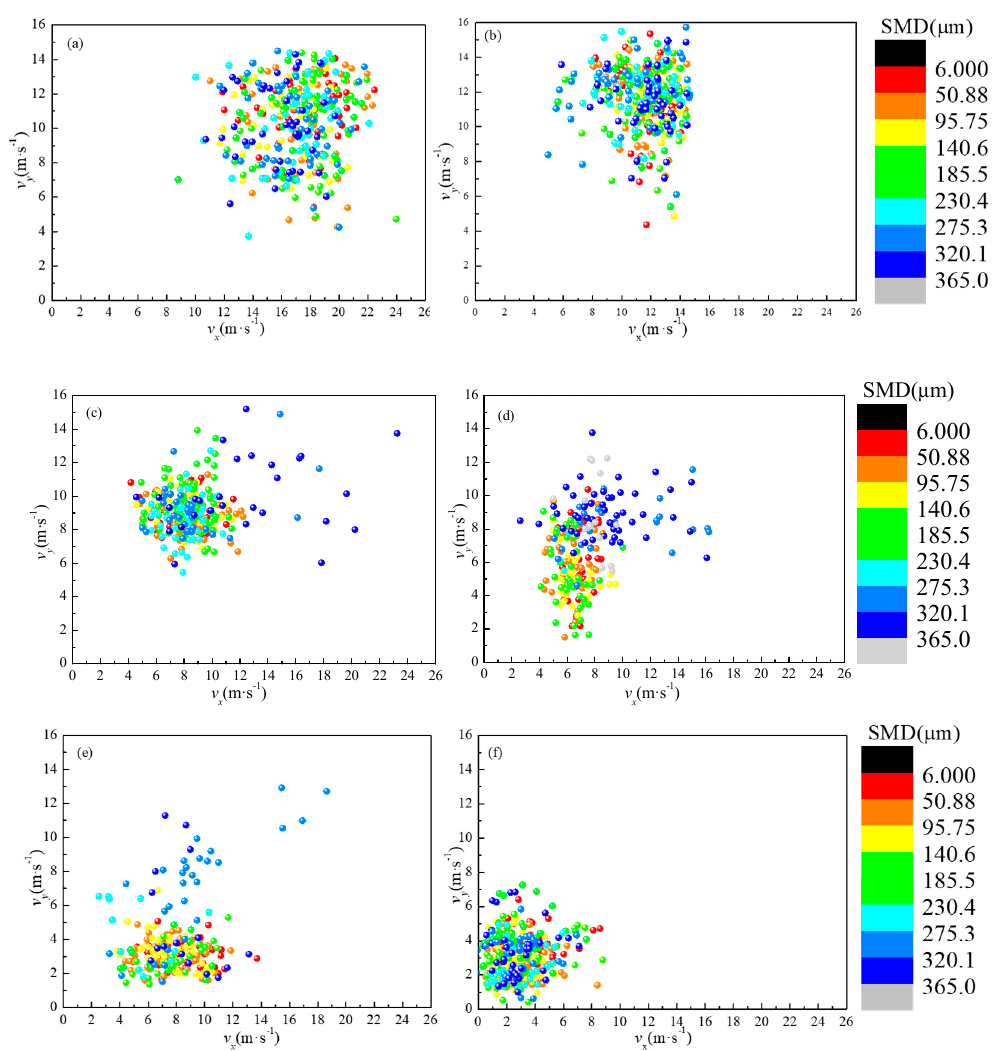
Figure 12. Joint particle size–velocity distribution scatter plot: ( a ) X = 50 mm, ( b ) X = 100 mm, ( c ) X = 200 mm, ( d ) X = 450 mm, ( e ) X = 600 mm, and ( f ) X = 800 mm.